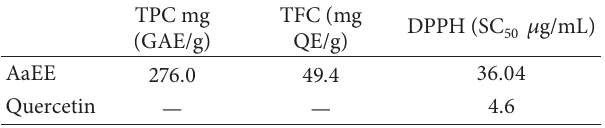
Table 1: Results of total polyphenol content (TPC) and total flavonoid content (TFC) and antioxidant capacity (SC) of